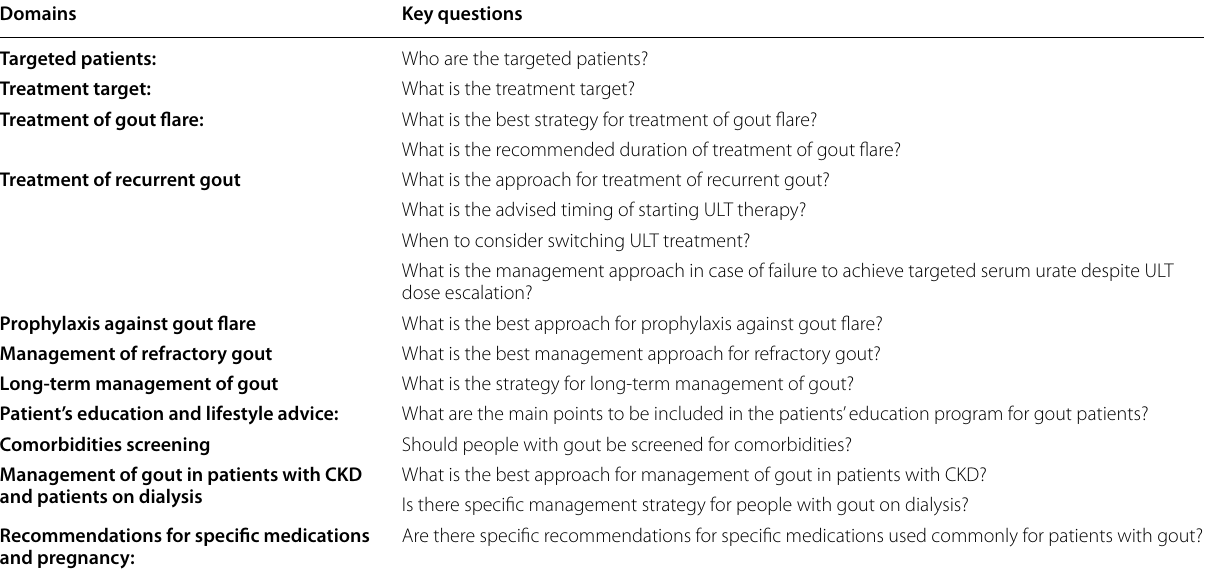
Table 1 Key questions used to develop the guidelines